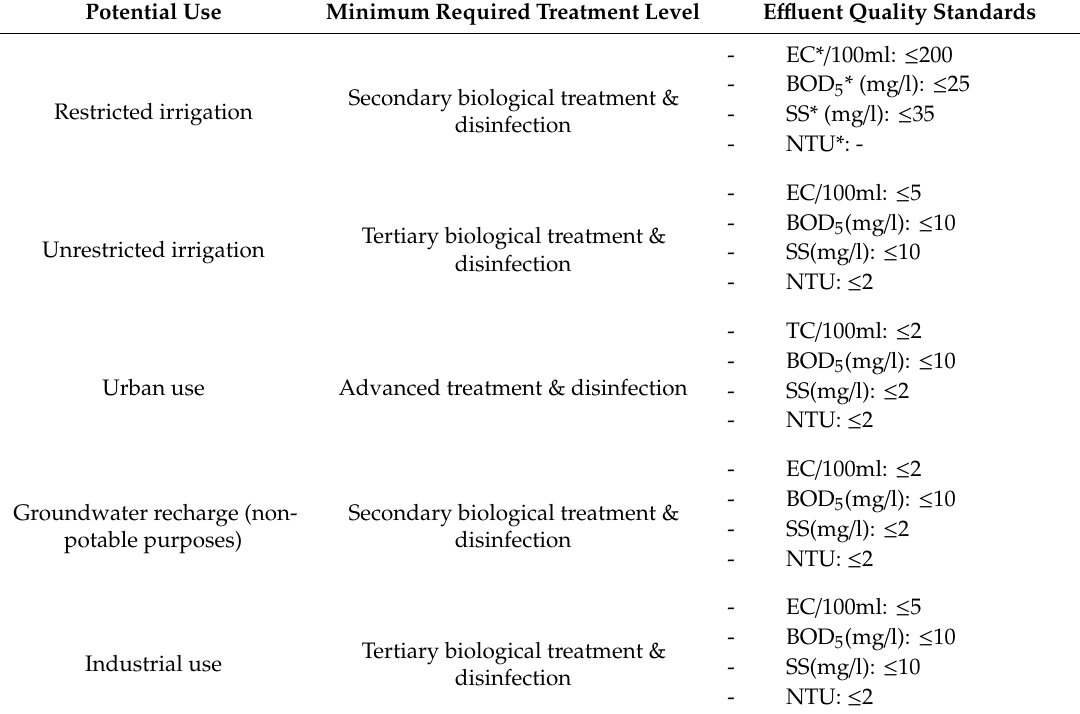
Table 1. Provisions of the Joint Ministerial Decree for wastewater reuse